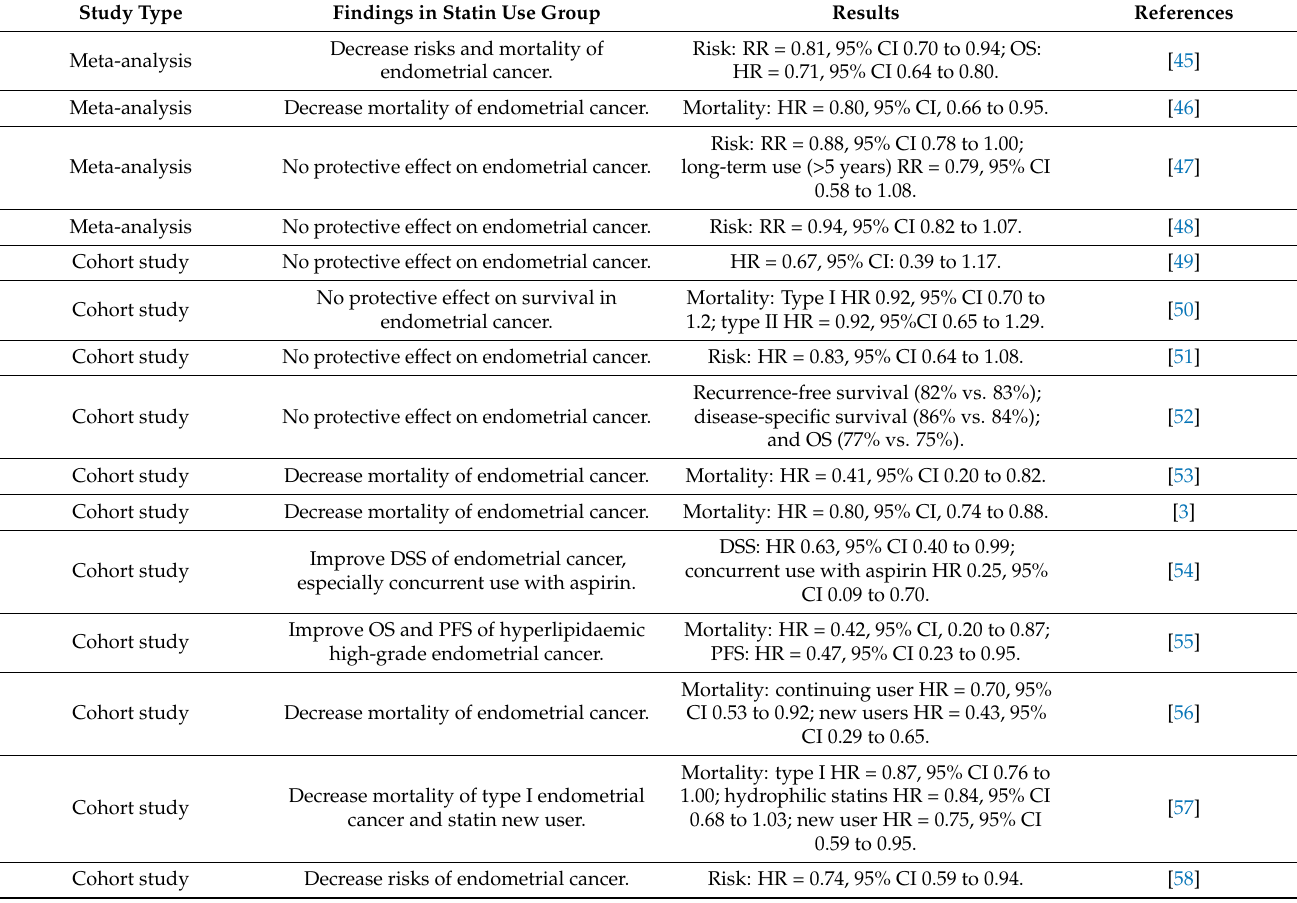
Table 2. Clinical studies of statins in endometrial